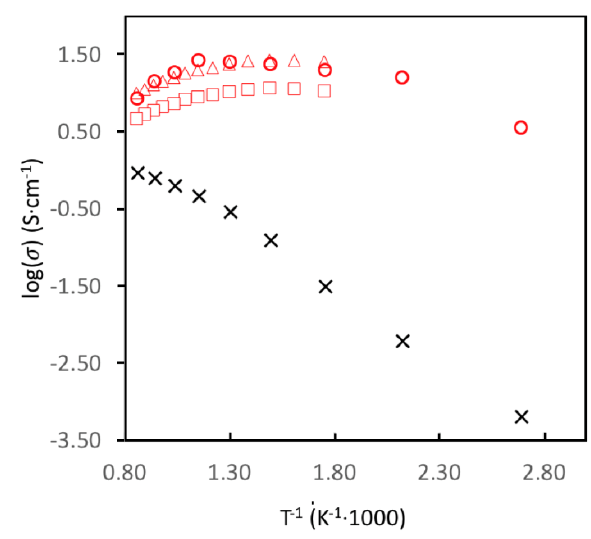
Figure 8. Electrical conductivity as a function of inverse temperature for as-prepared and air-annealed Sr 3 − x Pr x Fe 1.25 Ni 0.75 O 7 −δ , N 2 -annealed x = 0.2 (black crosses), air-annealed x = 0.2 (red circles) 0.3 (red triangles), 0.4 (red squares) RP samples.